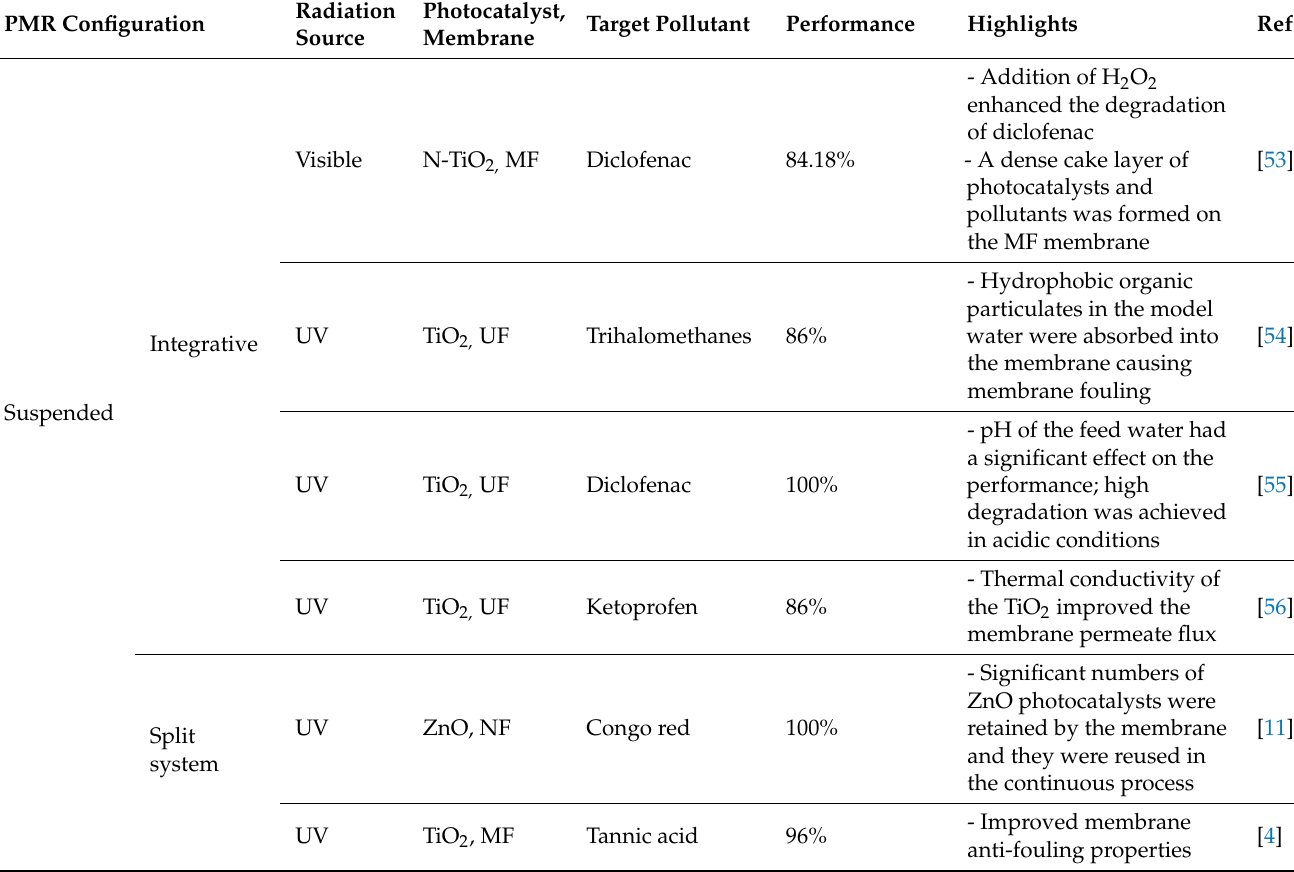
Table 1. Summary of the different PMR configurations used in the degradation of organic